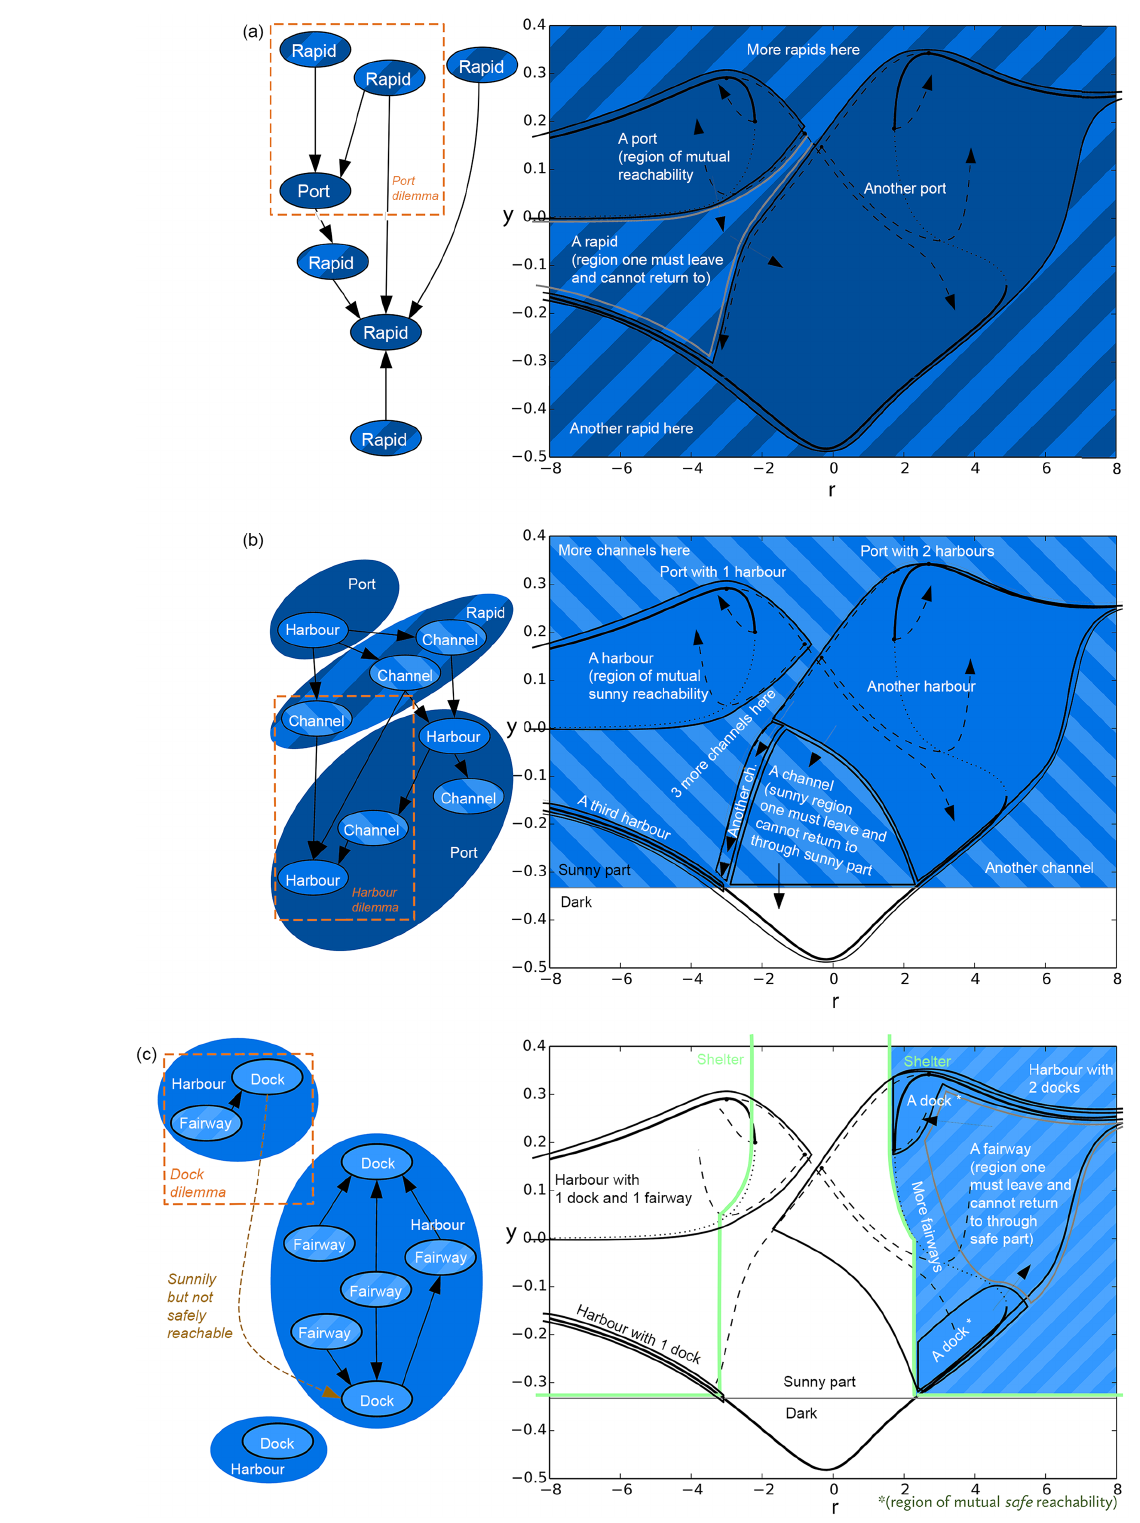
Figure 10. Main part of the three-level reachability network of ports and rapids (top panel), harbours and channels (middle panel), and docks and fairways (bottom panel, and related dilemmas in the bifurcation example. Arrows indicate stable reachability (top panel), stable reachability through the sun (middle panel), and stable reachability through the shelters (bottom panel). Some further arrows between rapids, channels and fairways have been omitted